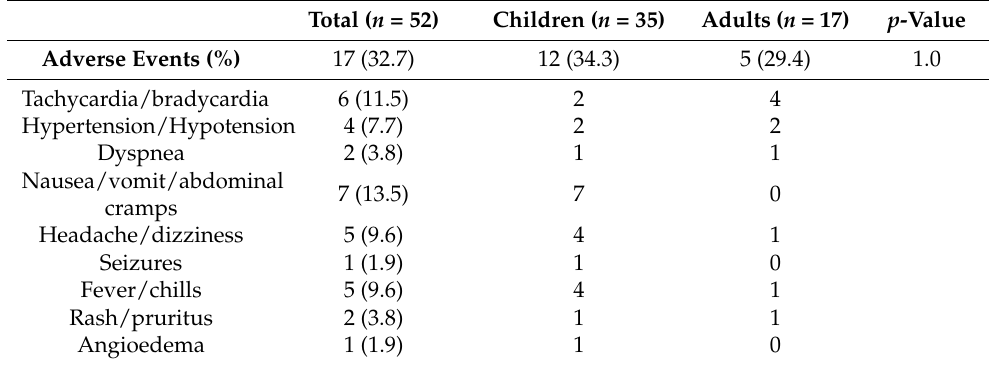
Table 3. Adverse events associated with MSC infusion according to the